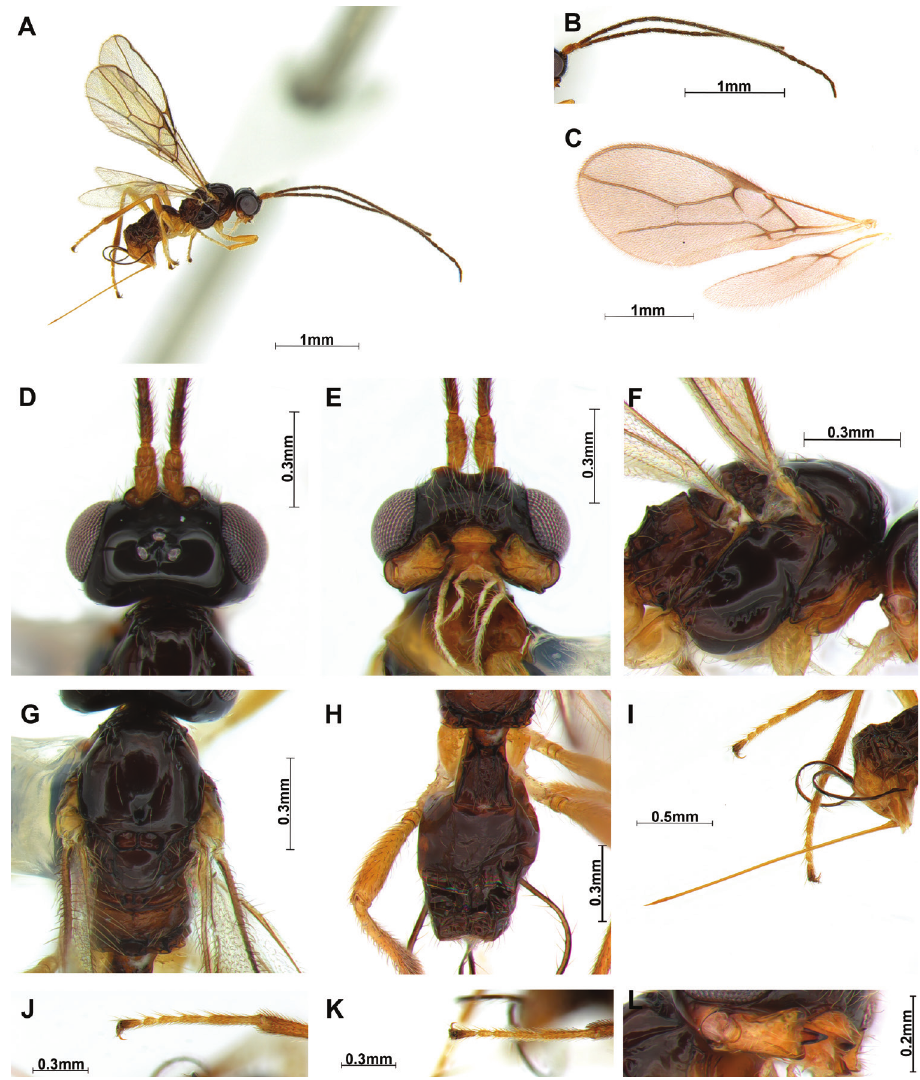
Figure 1. Phaenocarpa artotemporalis sp. nov., ♀ A body B antennae C wings D head, dorsal E head, anterior F mesosoma, lateral G mesosoma, dorsal H propodeum and metasoma, dorsal I ovipositor and its sheaths, lateral J tarsus, lateral K tarsus, dorsal L mandible, height from ventral rim of antennal sockets to upper margin of clypeus; face with long setae. Eye in dorsal view 4.2 times as long as temple. Ocello-ocular line (OOL) 3.4 times longer than diameter of anterior ocellus; OOL:antero-posterior ocellar line